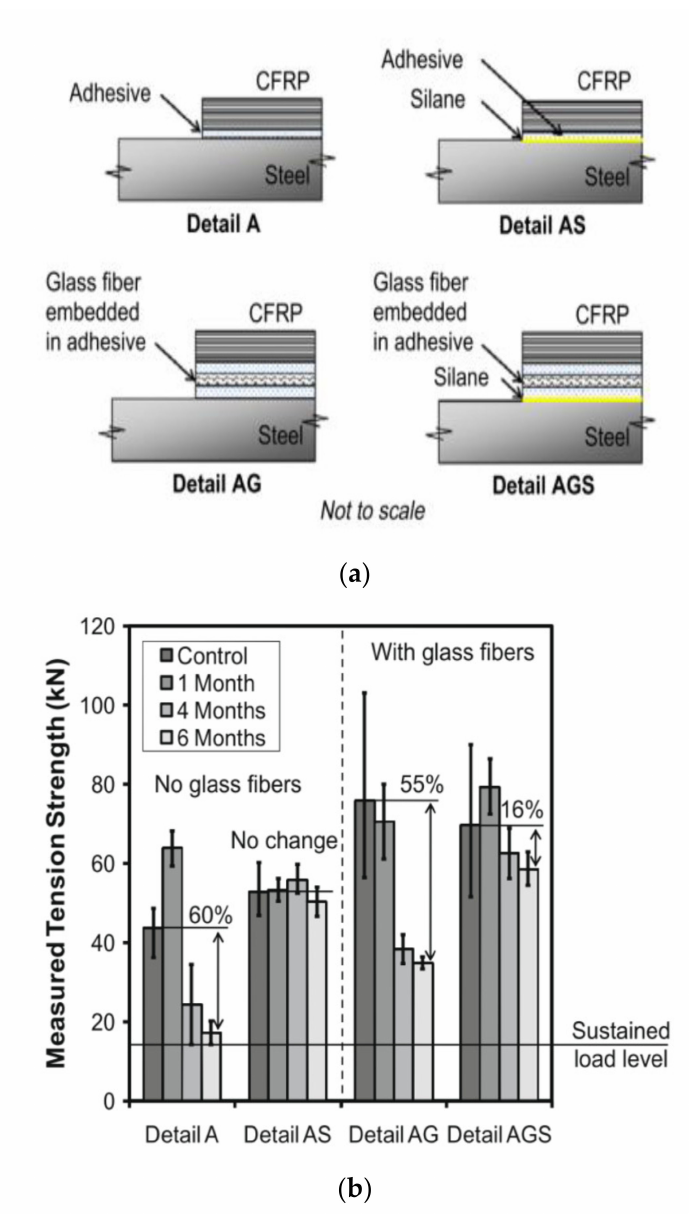
Figure 7. ( a ) Schematic representations of specimen configurations used in double lap bond joints. ( b ) Joint strength of various configurations after exposure with sustained load [59]; used with per- mission from Construction and Building Materials, Elsevier,